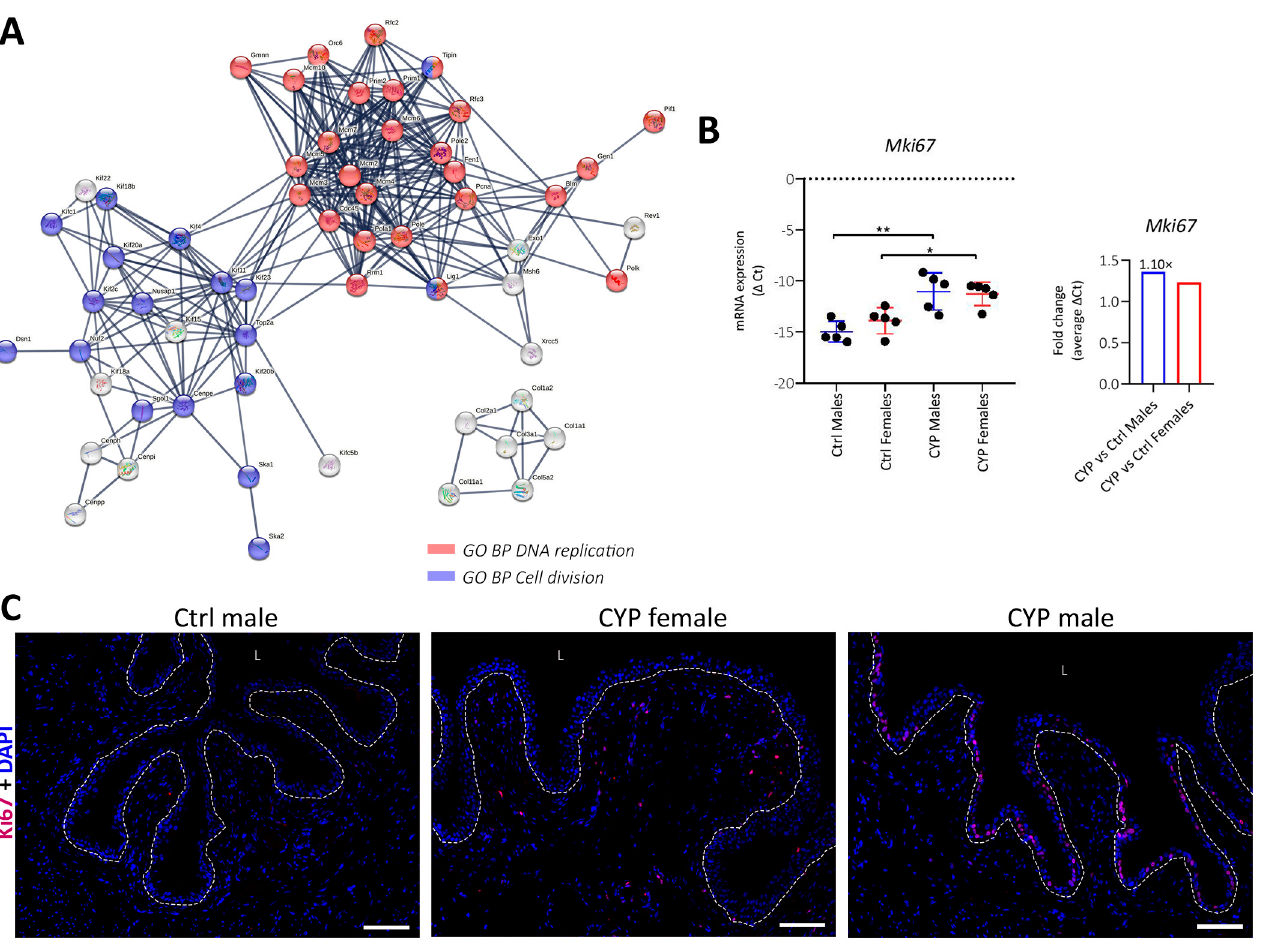
Figure 8. CYP-induced changes in the bladders of male mice. ( A ) STRING network shows interactions between the putative proteins of the significantly DEGs identified in the enriched GO biological processes involved in cell proliferation ( n = 76), displaying only interactions of the highest confidence (0.9). The proteins are known and predicted to interact during DNA replication (red) and cell division (blue). Disconnected nodes are hidden. ( B ) Left part of the panel: mRNA expression of Mki67 showing more significant upregulation of the transcripts in males compared to females after CYP treatment. Shown are the means ± SD of negative ∆ Ct determined for five animals per group. Right part of the panel: fold change of Mki67 mRNA expression in males and females after CYP treatment. ( C ) Representative images of Ki67 immunolabeled sections of the bladder wall of Ctrl male, CYP female, and CYP male show the differences in the distribution of Ki67-positive nuclei in the bladder wall. The dotted line represents the basal lamina. L; lumen of the bladder. Scale bar: 100 µm. * p < 0.05; ** p < 0.01.